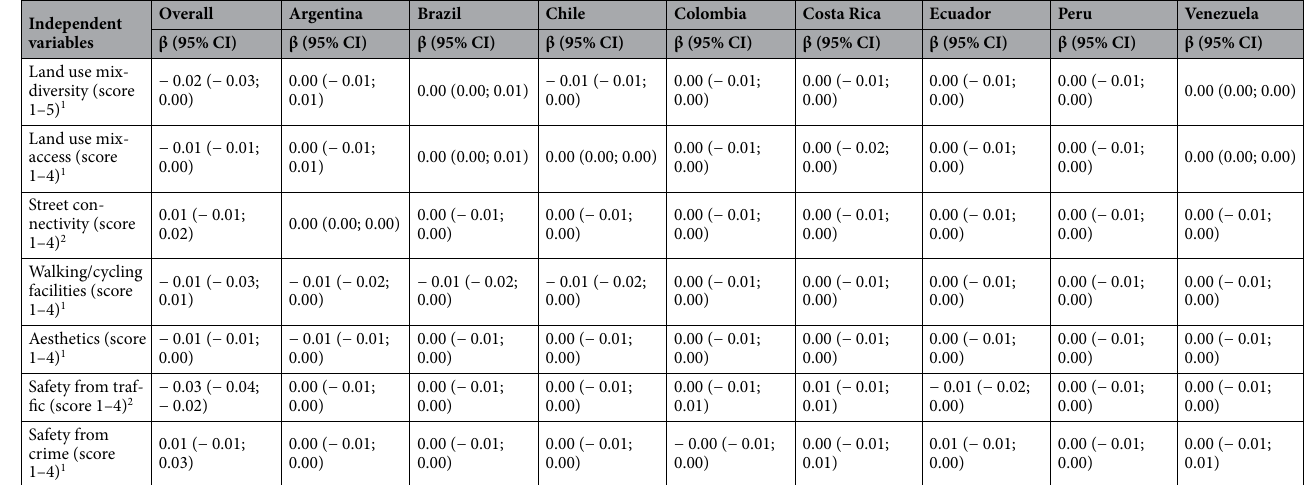
Table 5. Linear regression models (unstandardized β, 95% CI) for perceived urban environment attributes and a body shape index (cm). Linear regression models adjusted for age, sex, marital status, work status, socioeconomic level, and energy intake. *indicates statistically significant associations (p < 0.05). CI confidence interval. 1 Higher scores indicate perception of higher land use mix-diversity, higher land use mix-access, more walking/cycling facilities, better aesthetics, and more safety from crime. 2 4-point scale: strongly disagree (1), disagree (2), agree (3), strongly agree